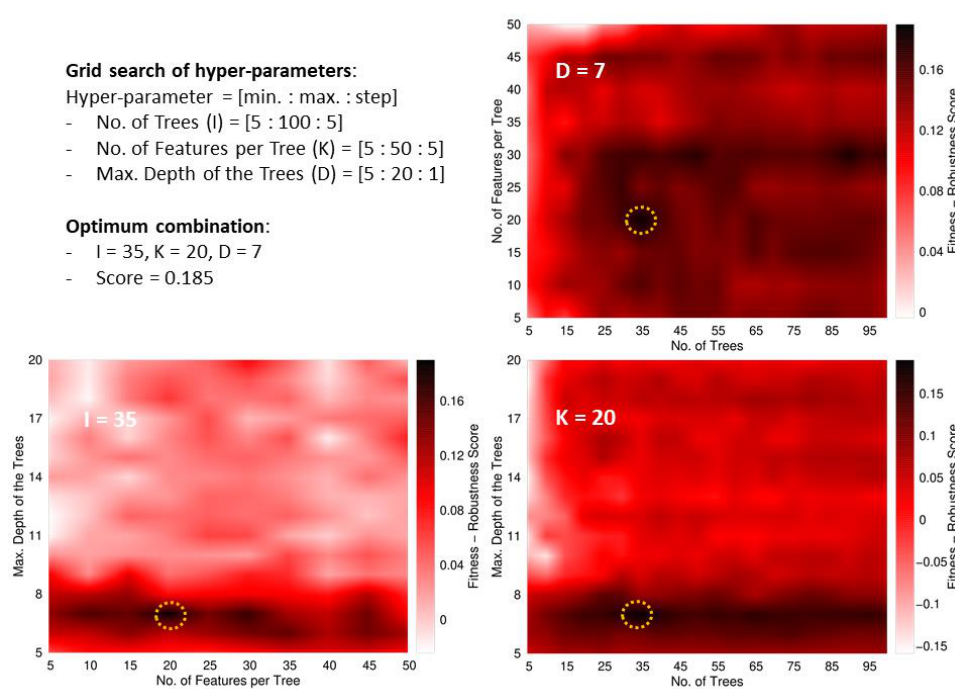
Figure 4. Tuning scheme of the RF’s hyper-parameters. The top-left panel summarizes the boundaries and binning of the grid search with the three hyper-parameters. This panel also shows the optimum value found for the FRS function and the hyper-parameters’ values of the corresponding solution. The remaining panels show surfaces plotted as heat maps keeping one of the hyper-parameters fixed at its optimum value. The dark regions indicate the best solutions. The optimum regions are highlighted with a dashed circle. As in the exploration for the model ABPs/non-ABPs, the plots show that the most critical parameter is the depth of the trees. Nonetheless, the opposite trend is observed because high-scored models are only obtained with low (<8) depth values. The smaller size of the dataset for this model, as compared with the previous one, leads to the occurrence of overfitting when deep trees are